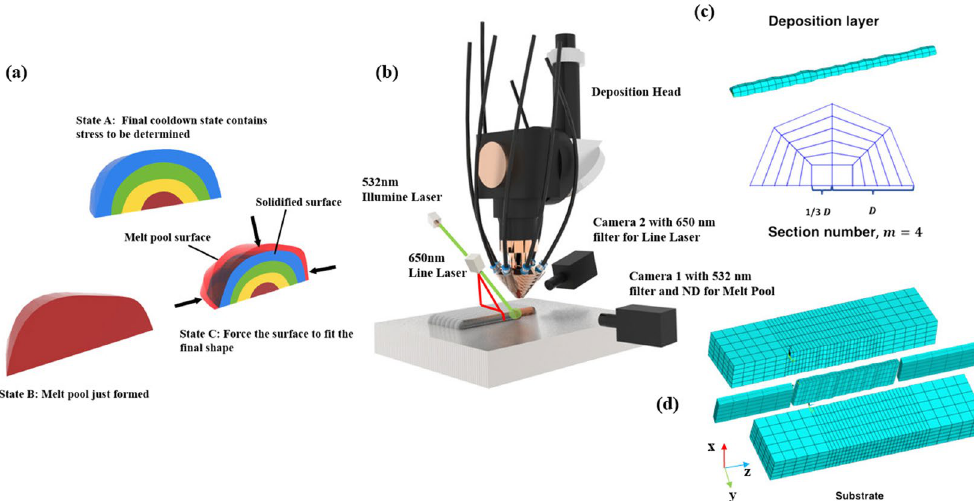
Figure 1. Schematic of real-time stress measurement. ( a ) The principle of displacement method, ( b ) real-time measuring system, ( c ) deposition layer model based on molten pool shape, ( d ) substrate